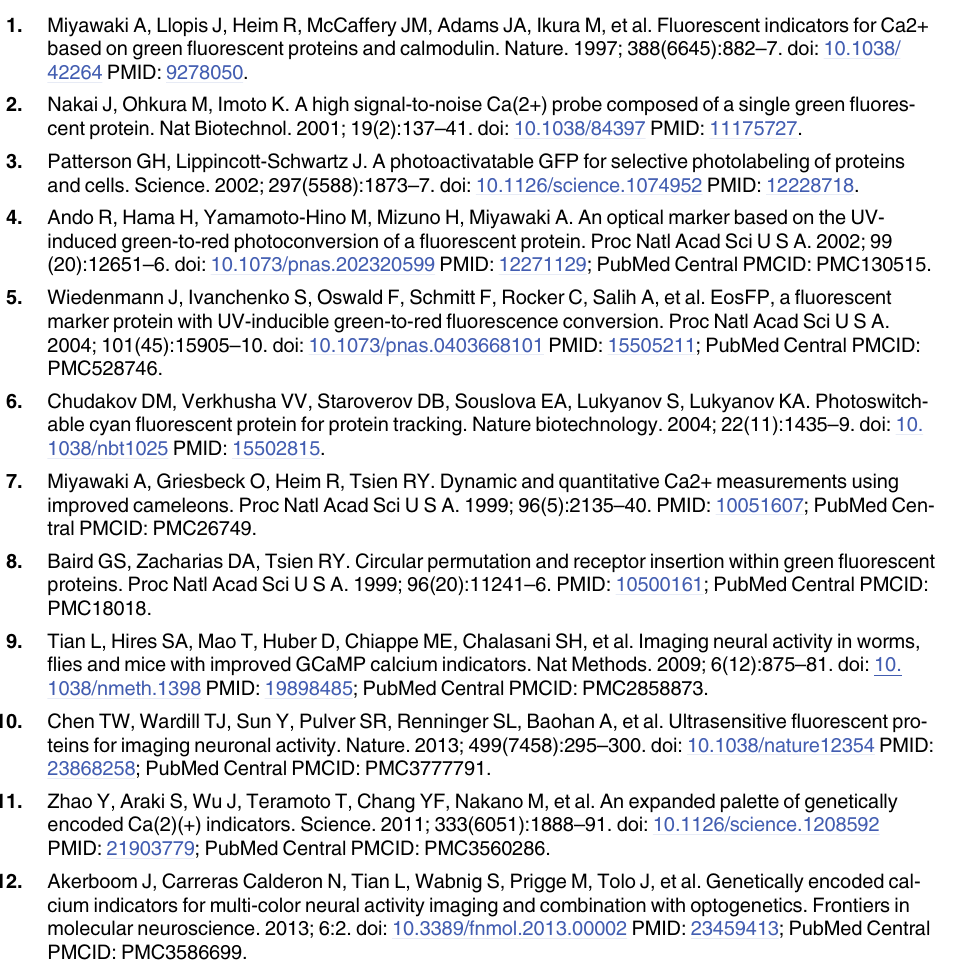
S4 Fig. Converted red fluorescence of purified GCaMP decays after several hours. Purified GCaMP3 was subjected to blue light-induced photoconversion in the presence of 5mM potas- sium ferricyanide and monitored for several hours. Top: green channel; bottom: red channel.